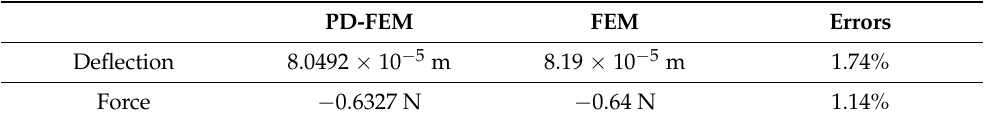
Figure 5. Vertical displacement on central axis of the beam. 4.2. Failure of 2D Plate with Central Crack Mode-I crack is selected to simulate crack initiation and propagation along the plate. A 50 mm × 50 mm square plate with a 10 mm central pre-crack is stretched from both ends at a velocity of 50 mm/s, as shown in Figure 6.